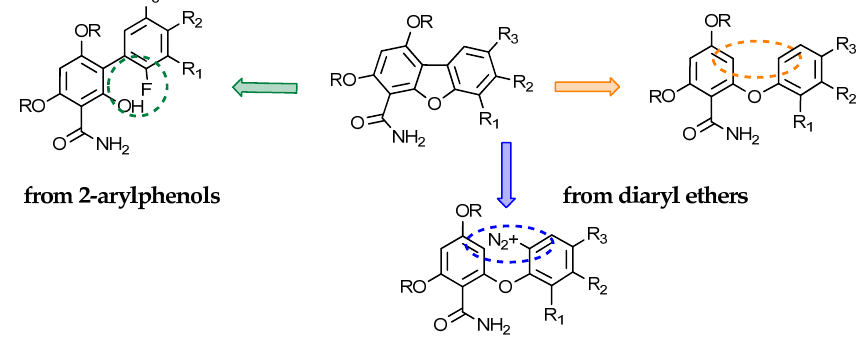
Figure 2. Proposed synthetic strategies to obtain the dibenzo[ b , d ]furan